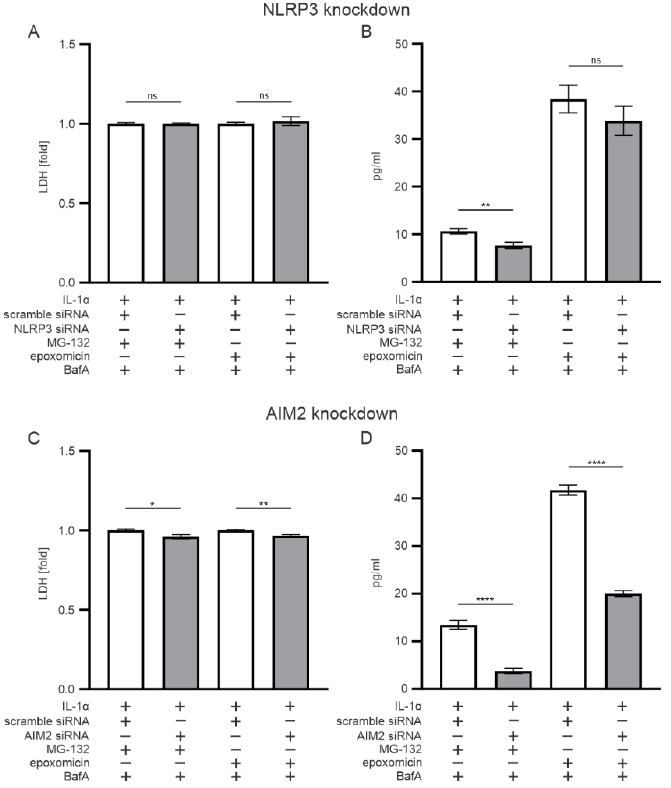
Figure 4. The role of ( A , B ) inflammasome receptors NLRP3 and ( C , D ) AIM2 on ( A , C ) cell viability and ( B , D ) IL-1 β levels in ARPE-19 cells. Data of LDH and IL-1 β were combined from three independent experiments with four parallel samples in each group. The results are presented as mean ± SEM. * p ≤ 0.05, ** p ≤ 0.01, **** p ≤ 0.0001; ns, not significant.